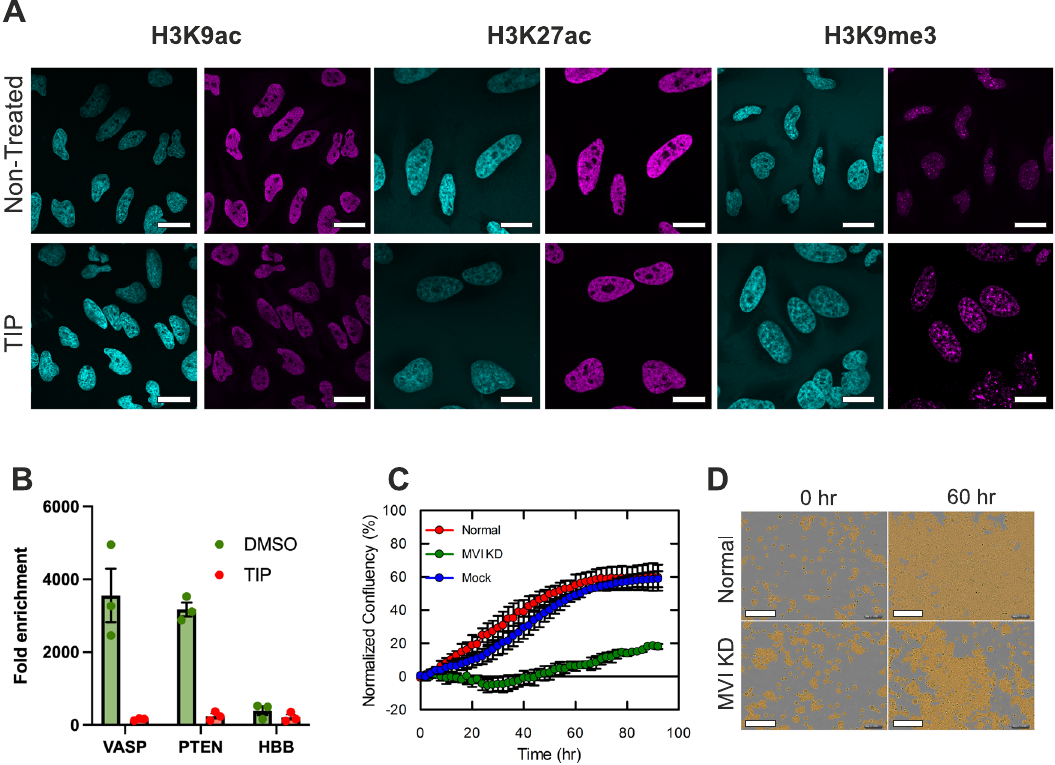
Fig. 6 Perturbation of myosin VI impacts chromatin organisation and cell growth. A Example immuno fl uorescence staining against stated histone marks (magenta) and DNA (blue) in HeLa cells under normal and TIP-treated conditions (scale bar 10 μ m). B Chromatin accessibility assay. qPCR was performed against the stated genes on chromatin puri fi ed from HeLa cells in the presence and absence of TIP. Chromatin was divided in to nuclease and control samples where nuclease activity was determined by difference between the two samples (Fold enrichment). HBB represents a repressed, inaccessible, control gene. Error bars represent SEM from three independent experiments. C Real-time growth of HeLa cells (red) and corresponding measurements following MVI (MVI) siRNA knockdown (green) and mock transfection control (blue). Data represent three independent measurements and error bars show SEM. Example images at start and 60 h time points are shown in ( D ) (scale bar 300 μ m in all images). Western blots are shown in Supplementary Fig. 17 for the MVI